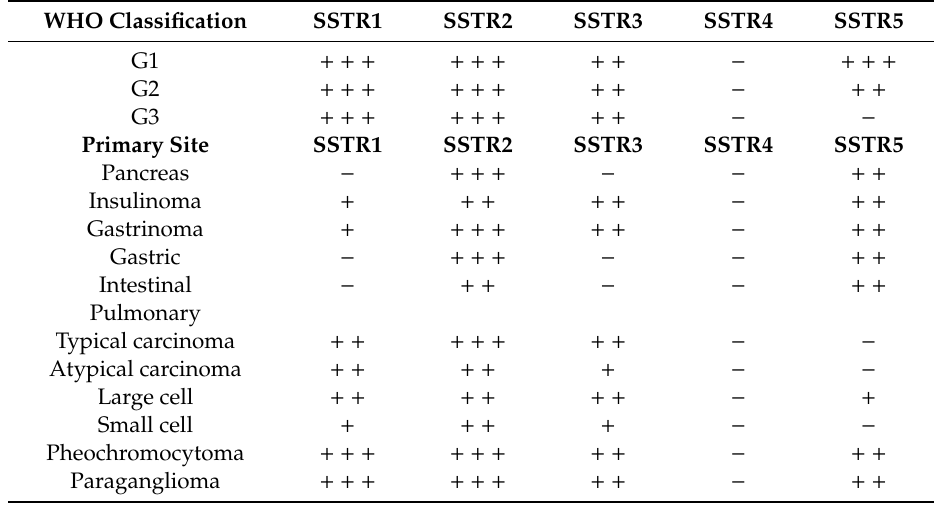
Table 1. SSTR expression in NETs according to WHO classification and primary site. + + + ,